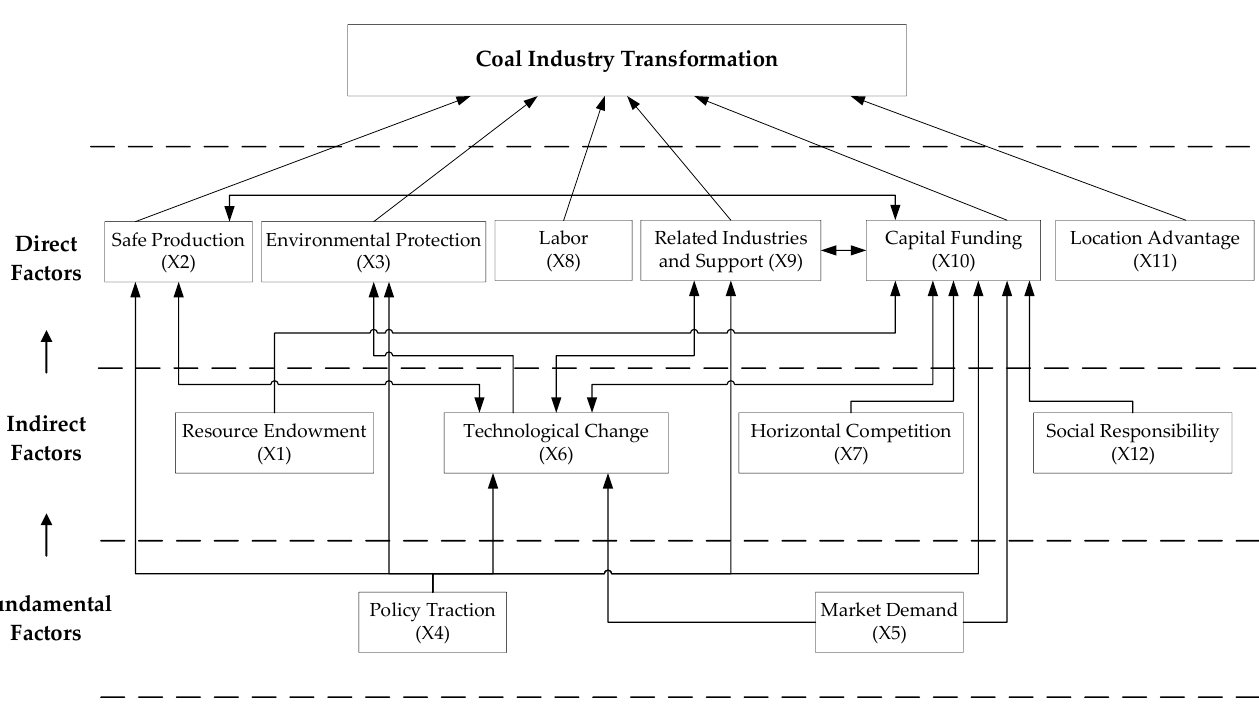
Figure 4. Hierarchical structure